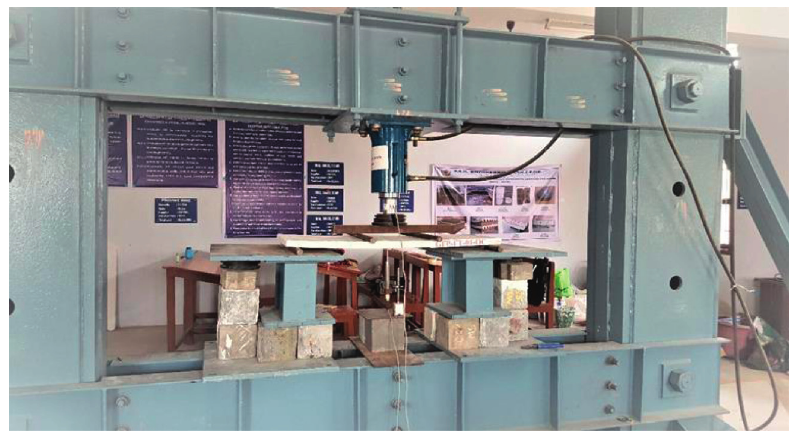
Figure 8: Flexural test on the GF flat panel.